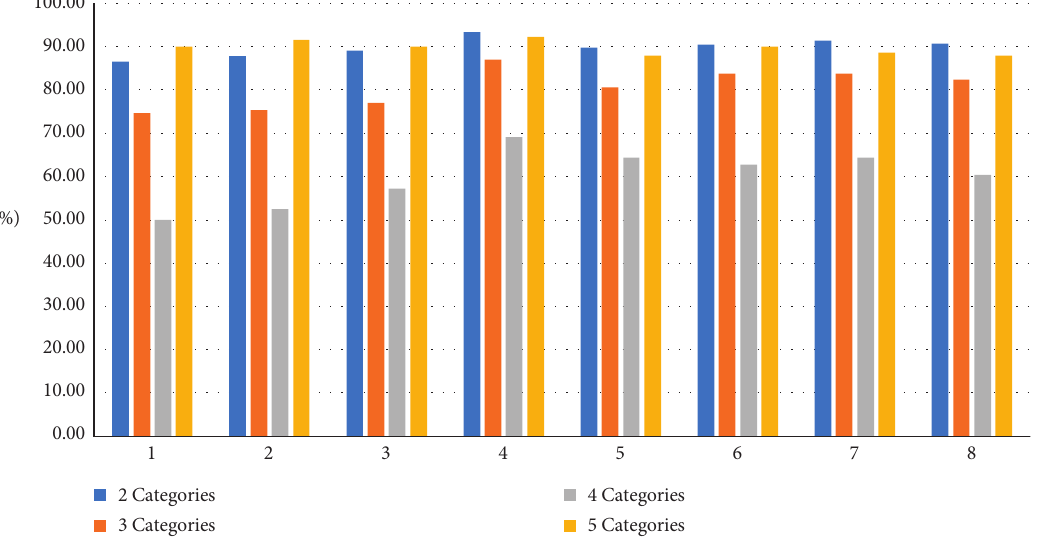
Figure 6: Average disambiguation accuracies from Experiment 1 to Experiment 8 under different number of